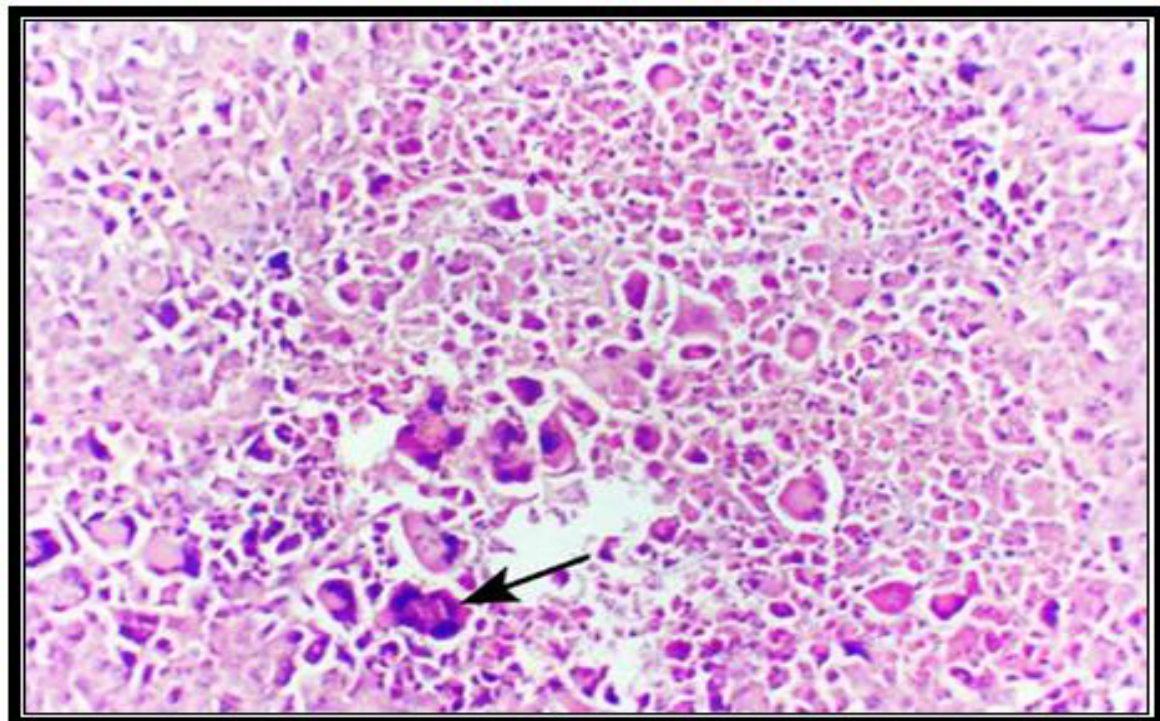
Figure 4. Malignant tumor of Ehrlich ascites carcinoma (EAC) bearing mouse treated with indoloquinoline compounds 6a , 6b , 6c and 6d showed criteria of anaplasia, necrosis. Moreover, small clusters of apoptotic cells (arrow) were observed. The apoptotic cells displayed dense basophilic nuclei and dense eosinophilic cytoplasm. (H and E × 200).